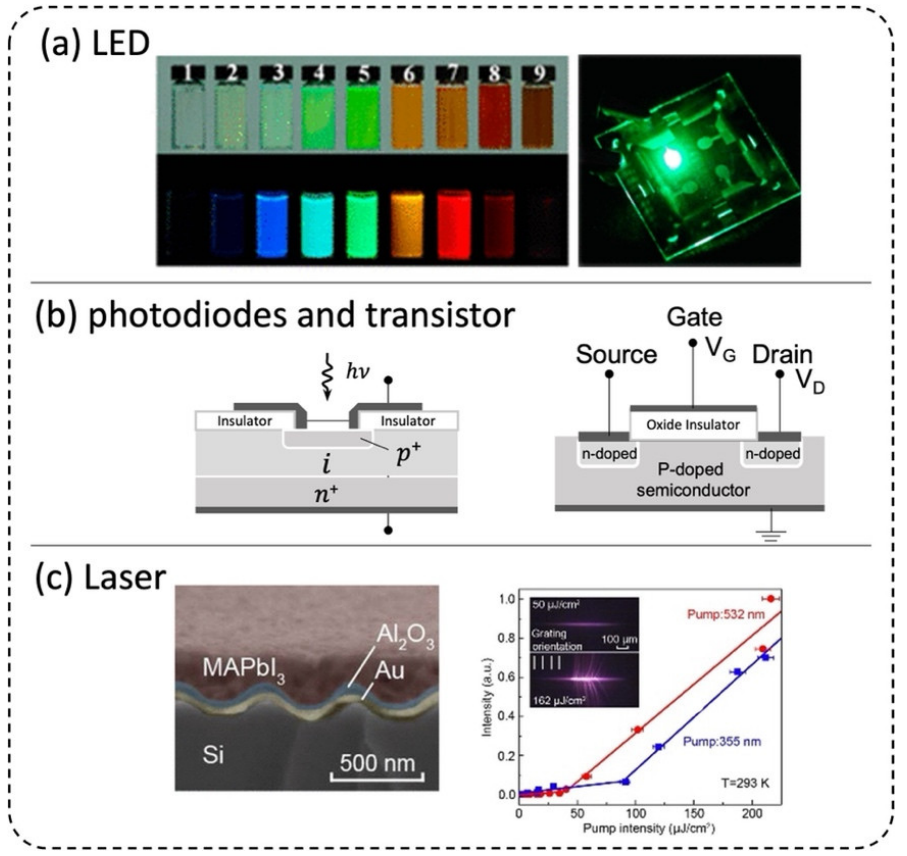
Figure 4. Optoelectronic applications of perovskite. ( a ) Color-tunable CH3NH3PbX3 (X = Cl, Br, or I) QDs and perovskite LEDs. Adapted with permission from Refs. [10,64]. Copyright 2020 American Chemical Society and 2017 American Chemical Society, respectively. ( b ) Schematic diagram of p - i - n photodiodes and MOSFET. ( c ) Cross-sectional profiles and threshold of MAPbI3 DFB laser. Adapted with permission from Refs. [67]. Copyright 2016 American Chemical Society.